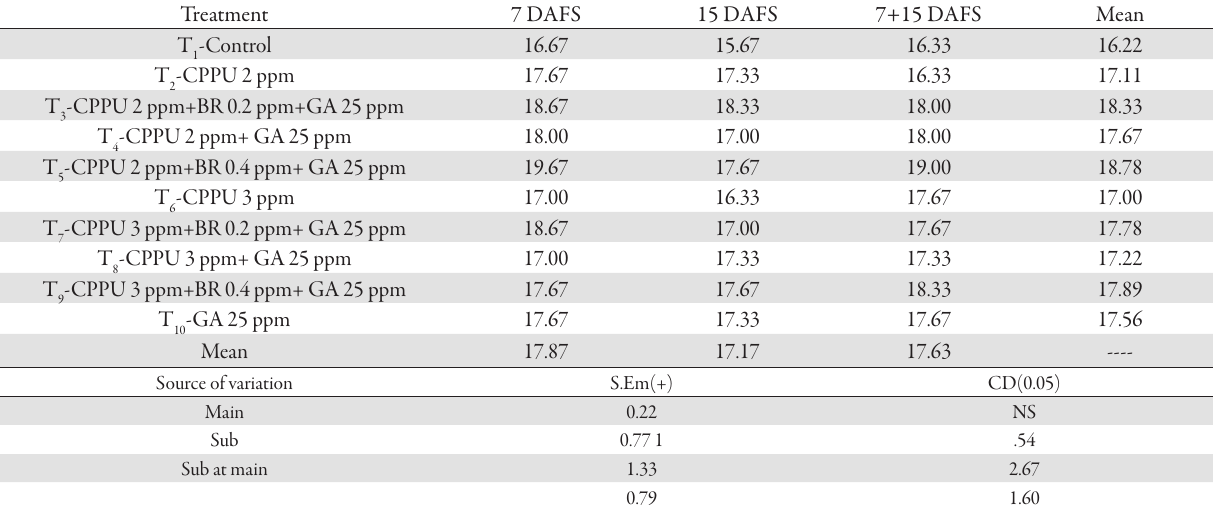
Tab. 1. Effect of growth regulators at different days after fruit set (DAFS) on number of leaves per shoot in grape Cv.’Tas-A-